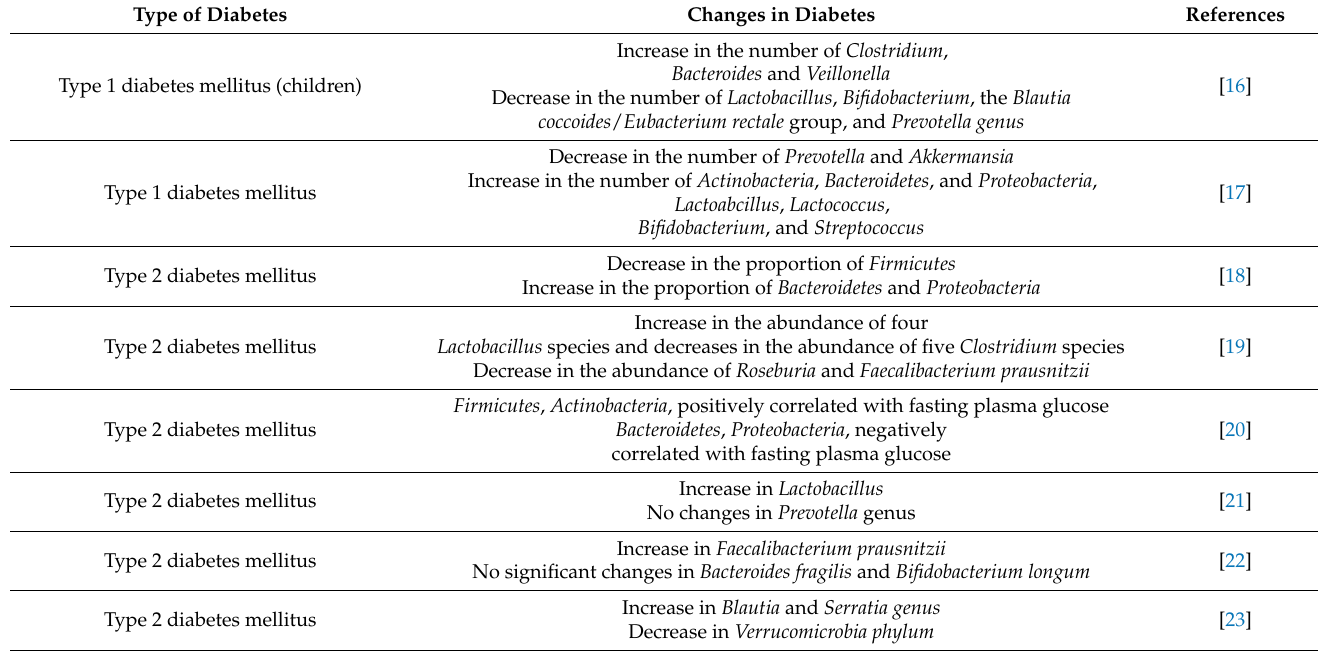
Table 1. Changes in the composition of the gut microbiota in patients with diabetes mellitus in clinical